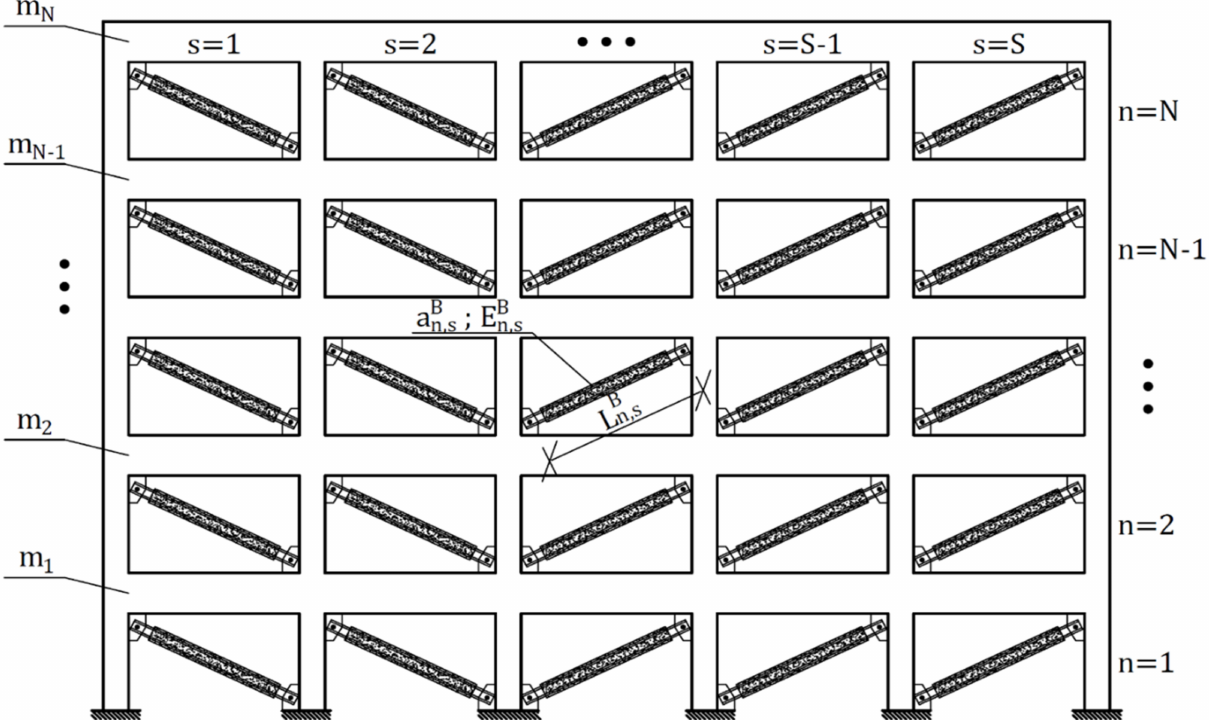
Figure 4. Rigid frame system elevation scheme equipped with